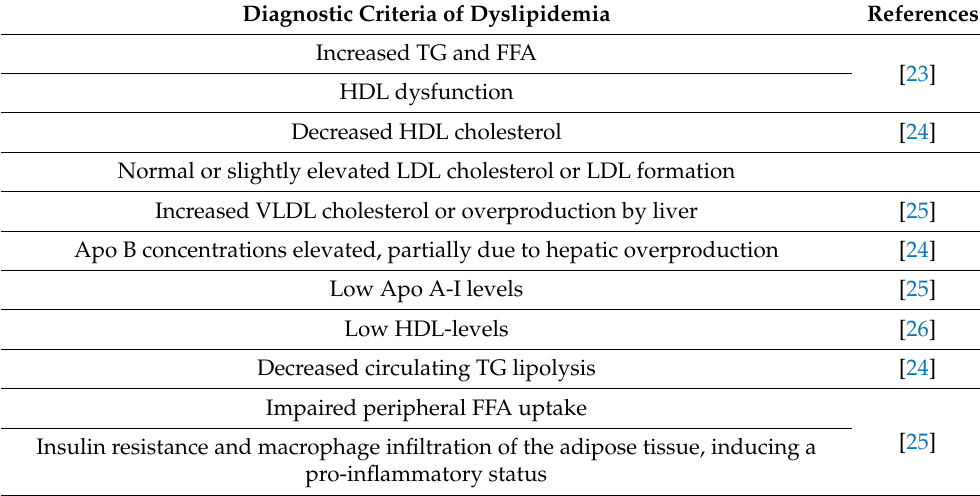
Table 1. Dyslipidemia clinical profile. Diagnostic Criteria of